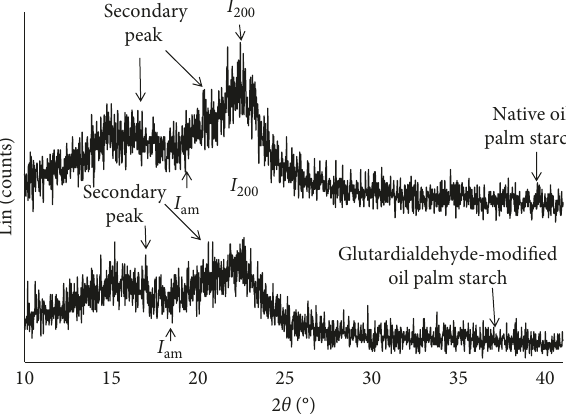
Figure 3: X-ray diffraction pattern of powdered samples from wood composite made using OPSMG and